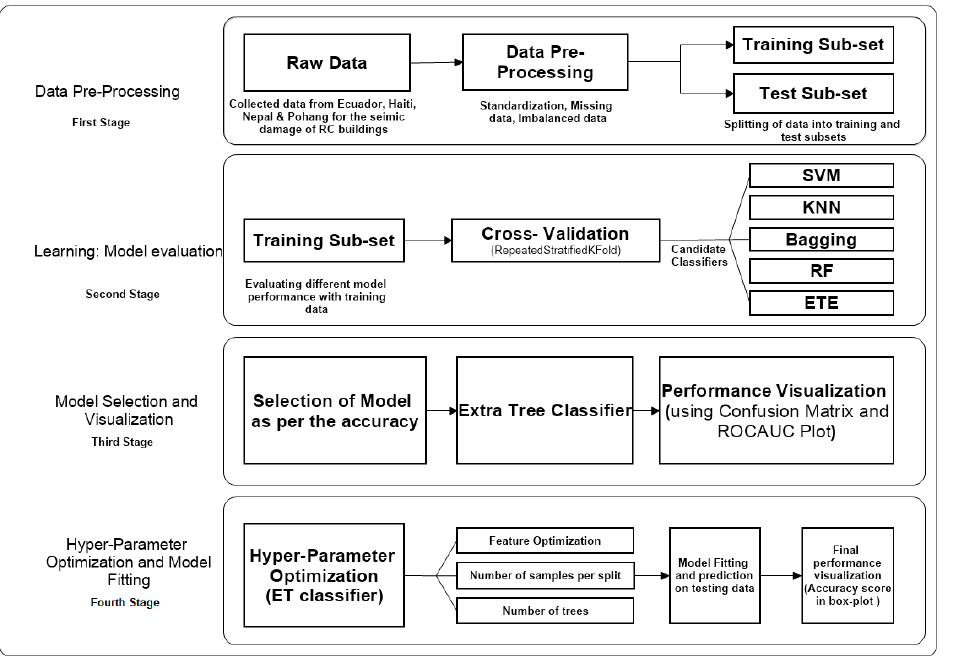
Figure 8. Methodology Flowchart: The given flowchart shows the steps involved to build and evaluate different classifiers on the given input